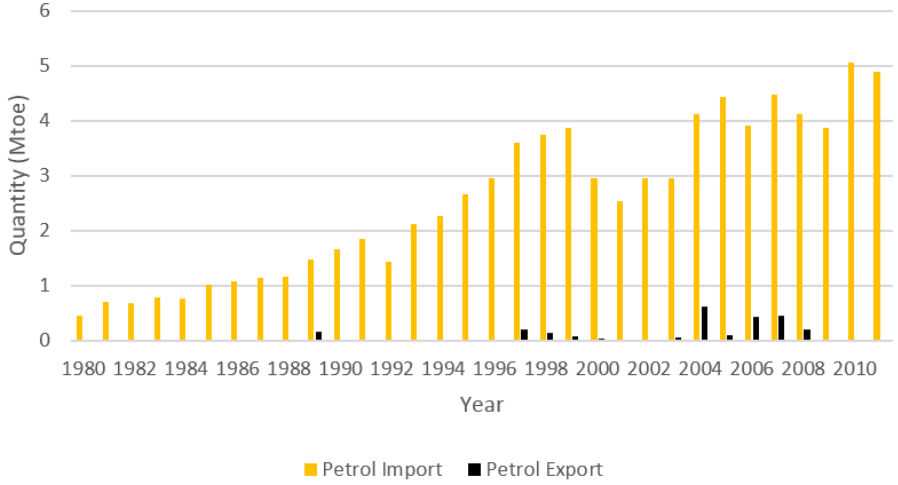
Figure 27. Petrol import and export in Malaysia.